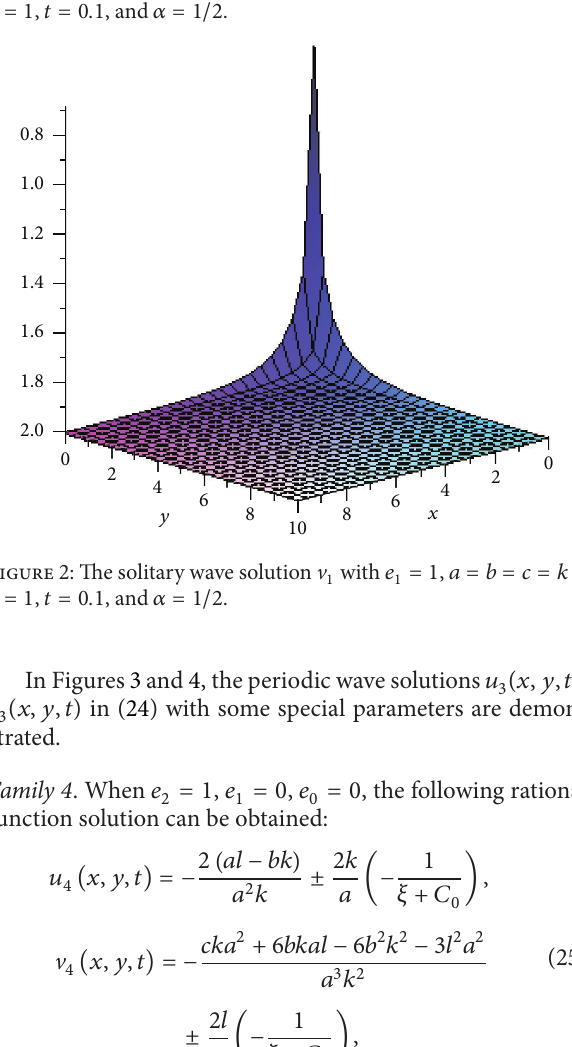
Figure 1: The solitary wave solution 𝑢 1 with 𝑒 1 = 1 , 𝑎 = 𝑏 = 𝑐 = 𝑘 = 1 = 1 , 𝑡 = 0.1 , and 𝛼 = 1/2 .